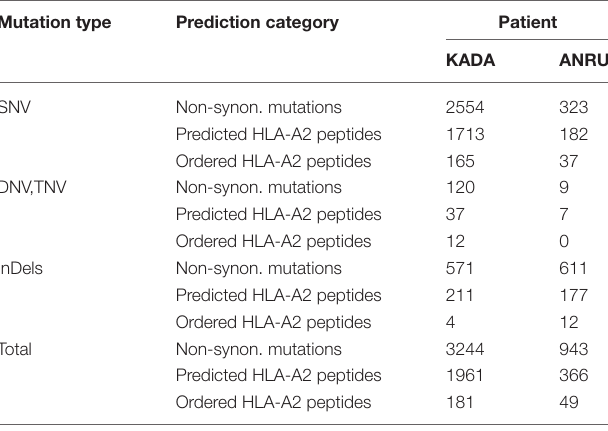
TABLE 1 | Selection of mutated peptides predicted to bind HLA-A2 with high affinity from whole exome sequences of tumor cell lines. Mutation